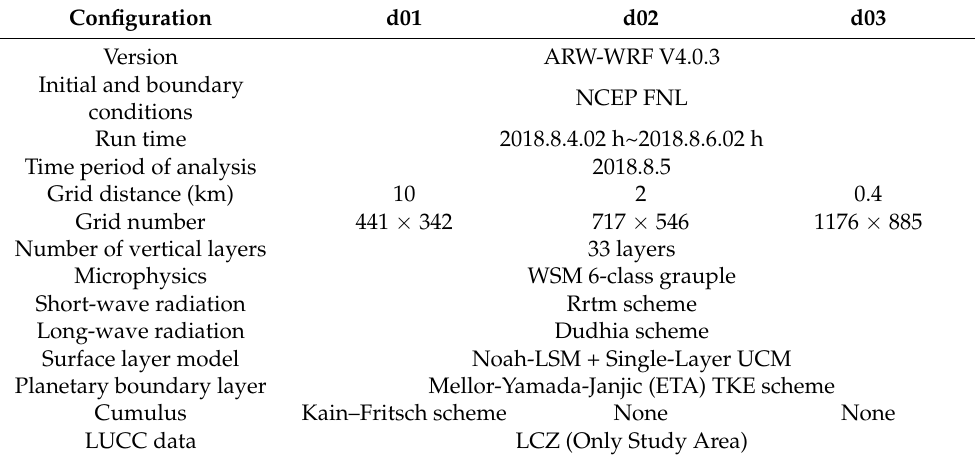
Table 1. Physical parameters in WRF-UCM V4.0.3.